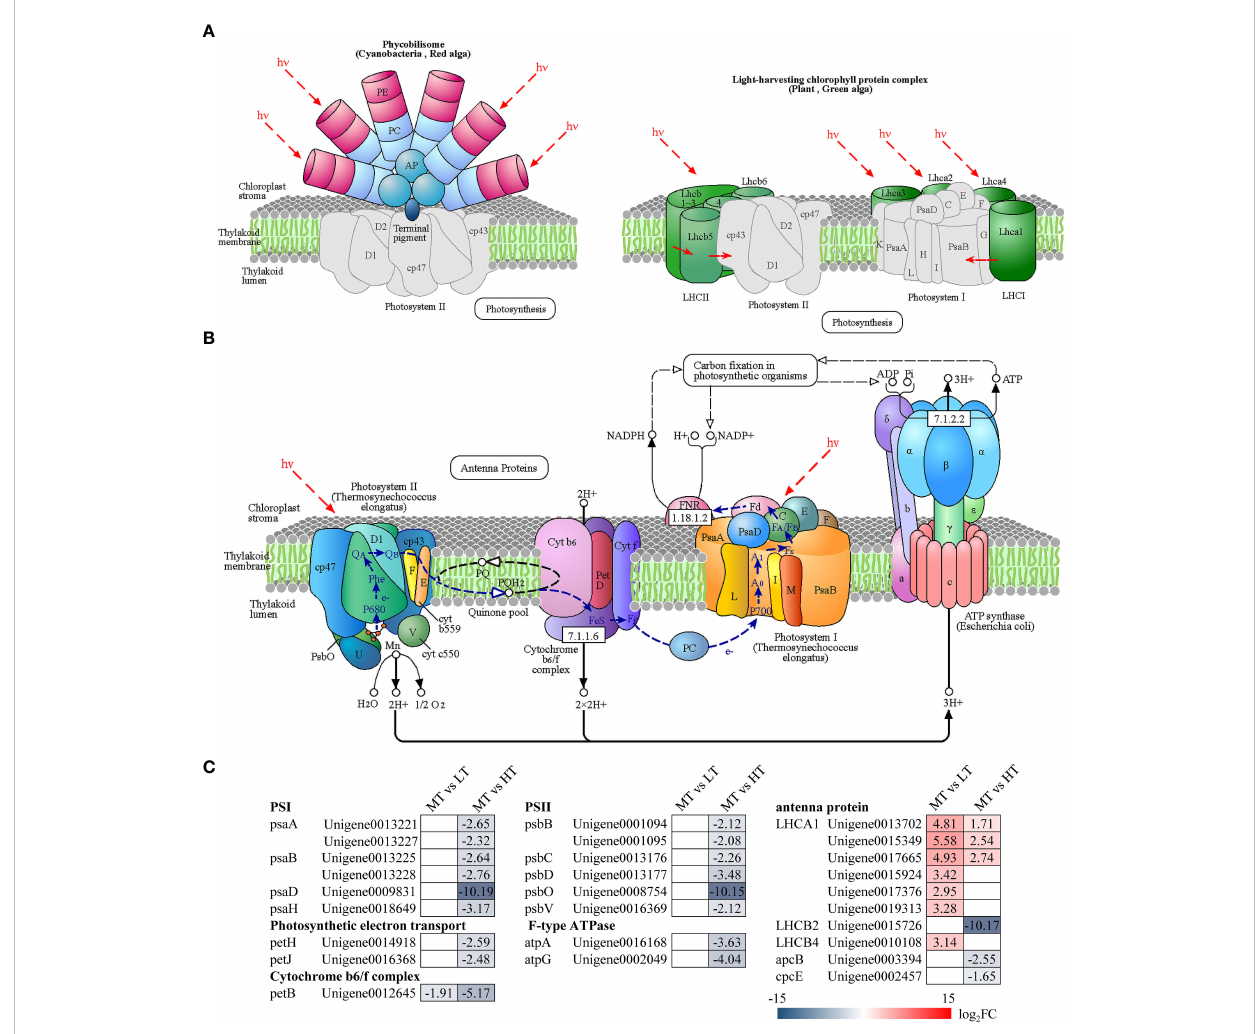
FIGURE 3 Pathways of photosynthesis and photosynthetic antenna proteins: (A) photosynthetic antenna protein pathway (ko00196), (B) photosynthesis pathway (ko00195), (C) DEGs involved in photosynthesis and photosynthetic antenna proteins. The number in each cell is the log2 fold change (log2FC). Red and blue gradients indicate the upregulation and downregulation of unigenes, respectively, while the white color represents log2FC < 1.5 or FDR > 0.05. The diagrams of photosynthesis and photosynthetic antenna proteins were obtained from the KEGG